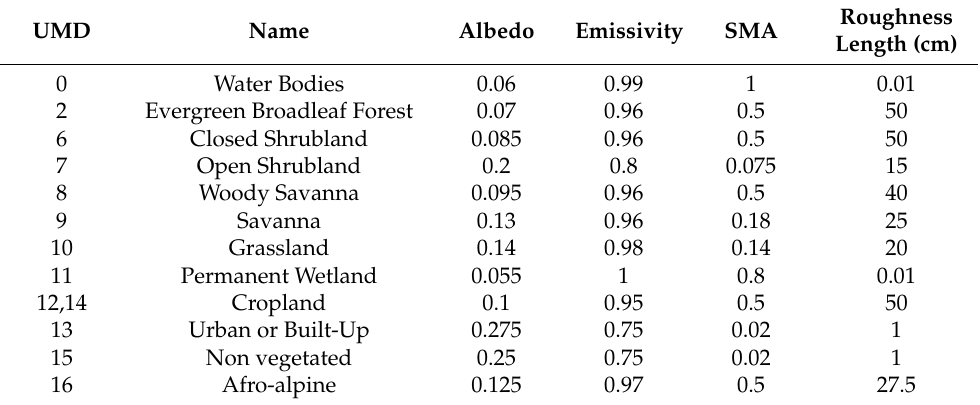
Table 2. Summary of input parameters used for each LC with UMD, name, albedo, emissivity, Soil Moisture Availability (SMA) and roughness length